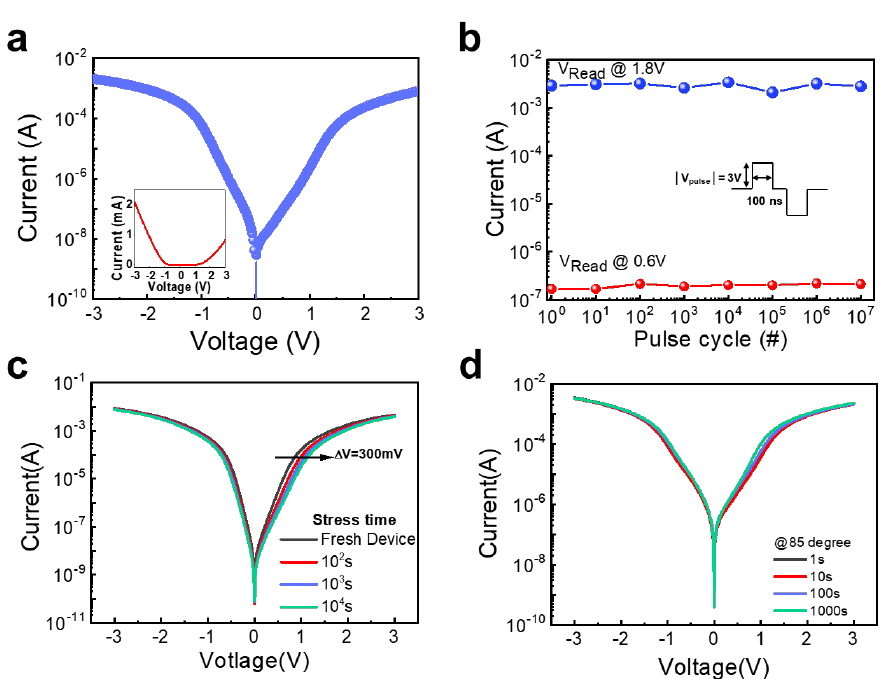
Figure 3. ( a ) I-V characteristics of oxygen plasma treated a-ITZO-selector device. The inset shows the linear I-V plot. Electrical stability tests under ( b ) cycling endurance and ( c ) constant bias stress. ( d ) Temperature stability test.